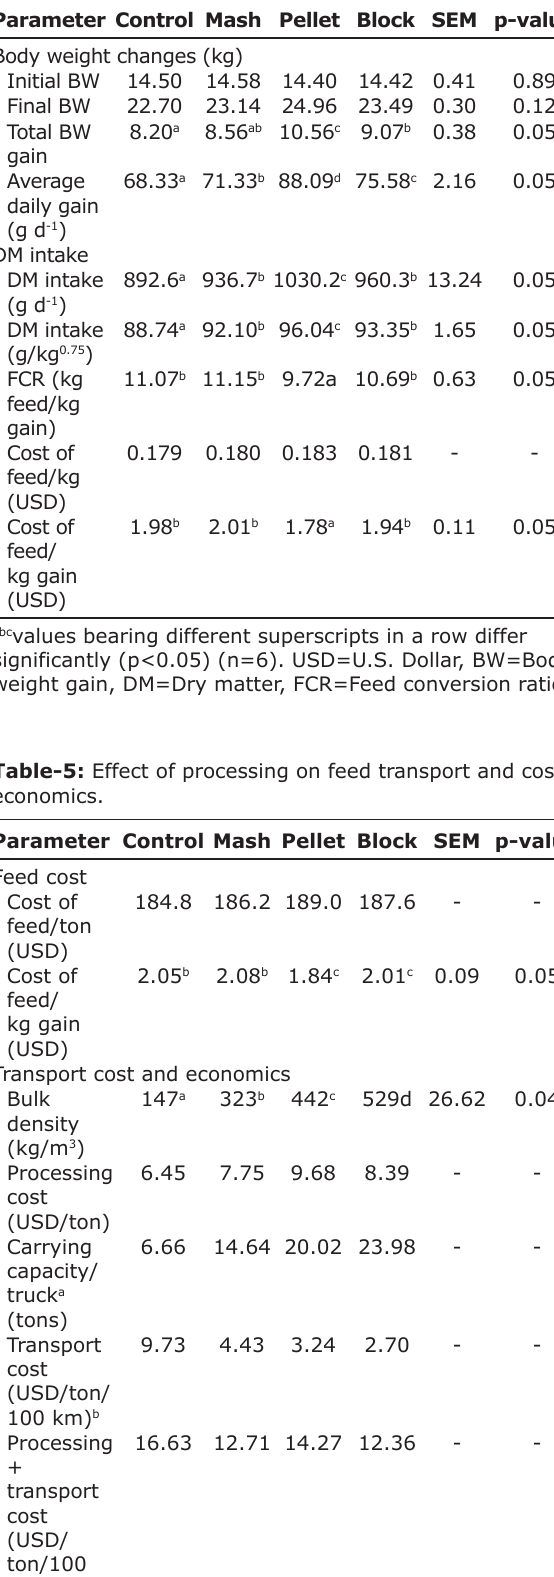
Table-4: Effect of feeding differently processed sorghum stover-based complete rations on growth rate and feed intake in lambs.